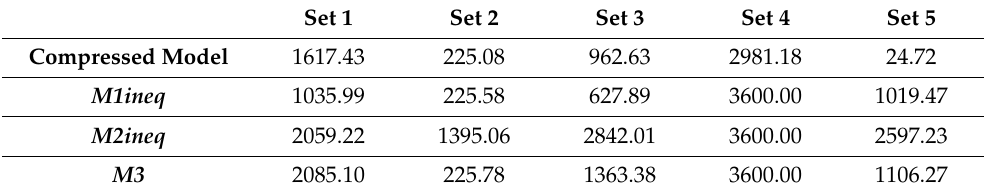
Table 7. Average computation time.